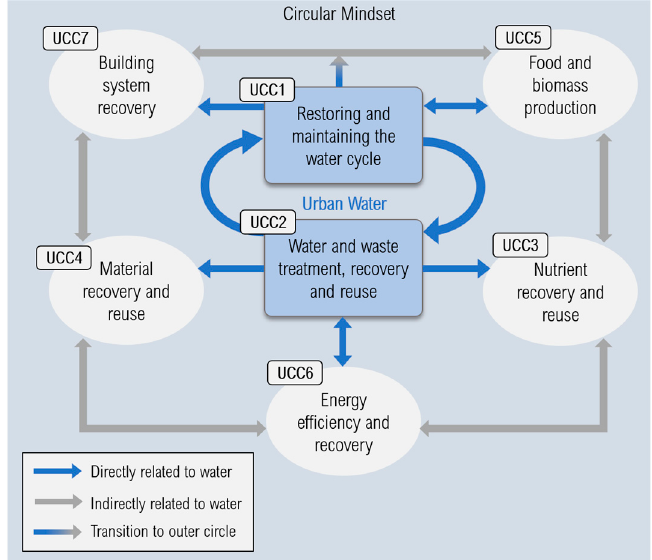
Figure 2. Diagram illustrating the interconnections between the seven circularity challenges from the perspective of urban water. The two central challenges of our analysis are (UCC1) restoring and maintaining the water cycle, and (UCC2) water and waste treatment, recovery and reuse.